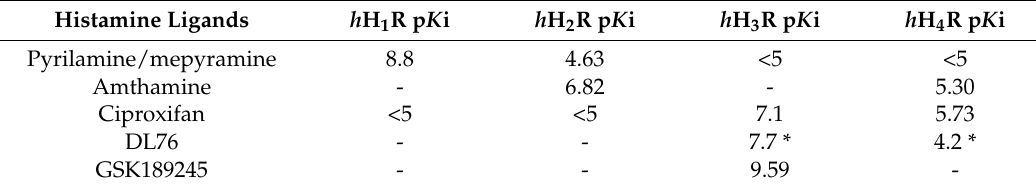
Table A1. Histamine ligands pKi modified